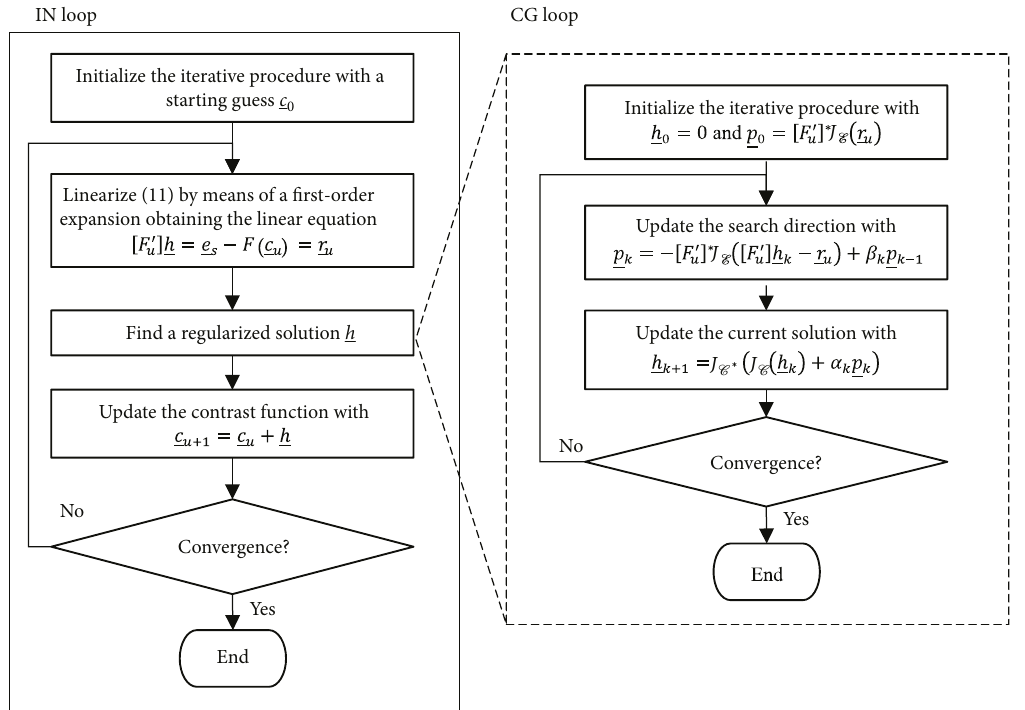
Figure 2: Flowchart of the developed l p Newton-CG inversion